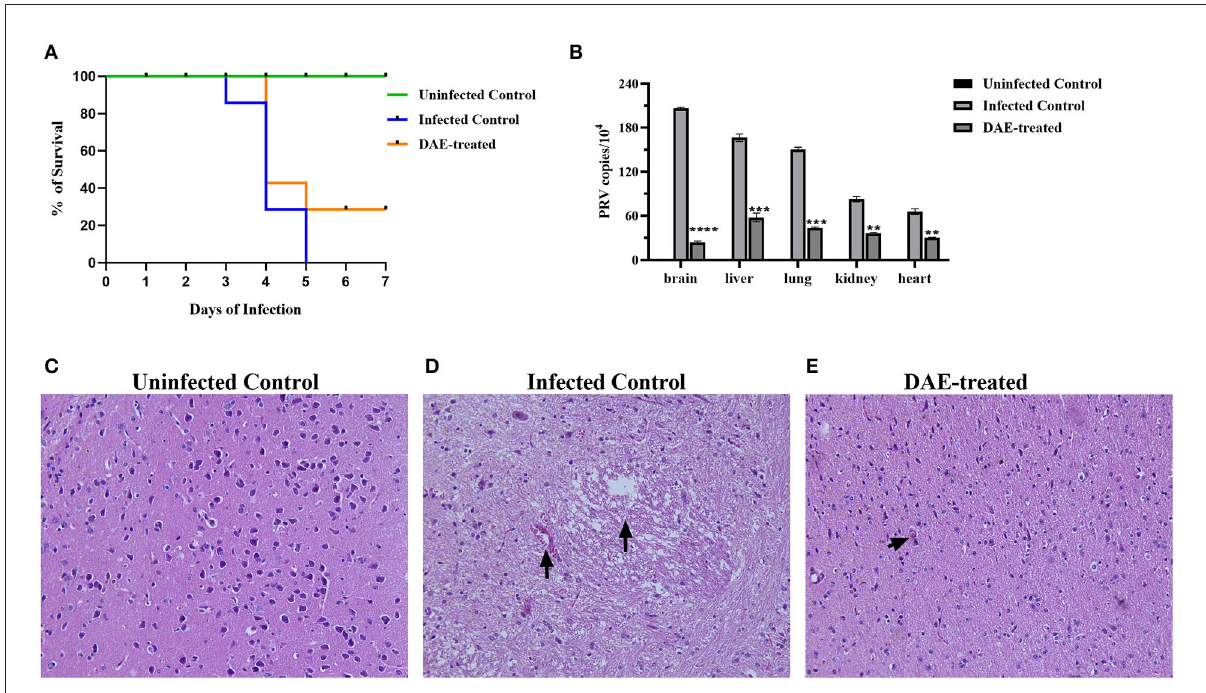
FIGURE5 DAE showed antiviral activity against PRV in mice. (A) The survival rate of mice in each group. (B) The viral load in the heart, kidney, liver, lung, and brain of mice in each group. The viral copy number in different organs was detected by FQ-PCR 76h after PRV challenge. Histopathological sections of mouse brain were harvested from the uninfected control (C) , infected control (D) , and DAE-treated (E) mice, with hematoxylin-eosin staining (**** P < 0.0001, *** P < 0.001, ** P < 0.01).